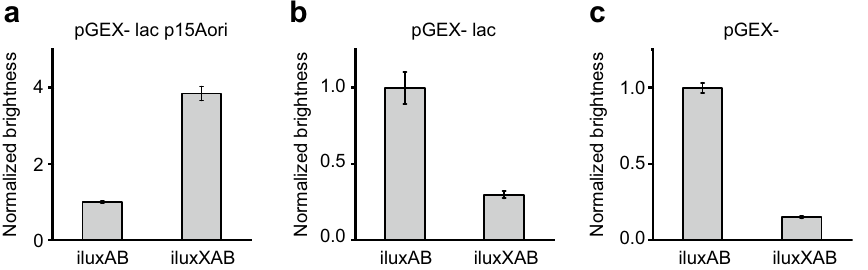
Figure 3. Mutagenesis and screening of iluxAB . Plots show the relative bioluminescence signal normalized to iluxAB . ( a ) For mutagenesis of iluxAB , iluxAB was expressed at low levels from the vector pGEX(−) lac p15Aori whereas iluxCDEfrp was simultaneously expressed at high levels from pGEX(−) Kan. Repeated rounds of mutagenesis resulted in the brighter variant iluxXAB . ( b ) Relative brightness of iluxAB and iluxXAB expressed from pGEX(−) lac. iluxCDEfrp was expressed from the same vector. ( c ) Relative brightness of iluxAB and iluxXAB expressed from pGEX(−). iluxCDEfrp was expressed from the same vector. Error bars represent standard deviation (SD) of 10 different clones.